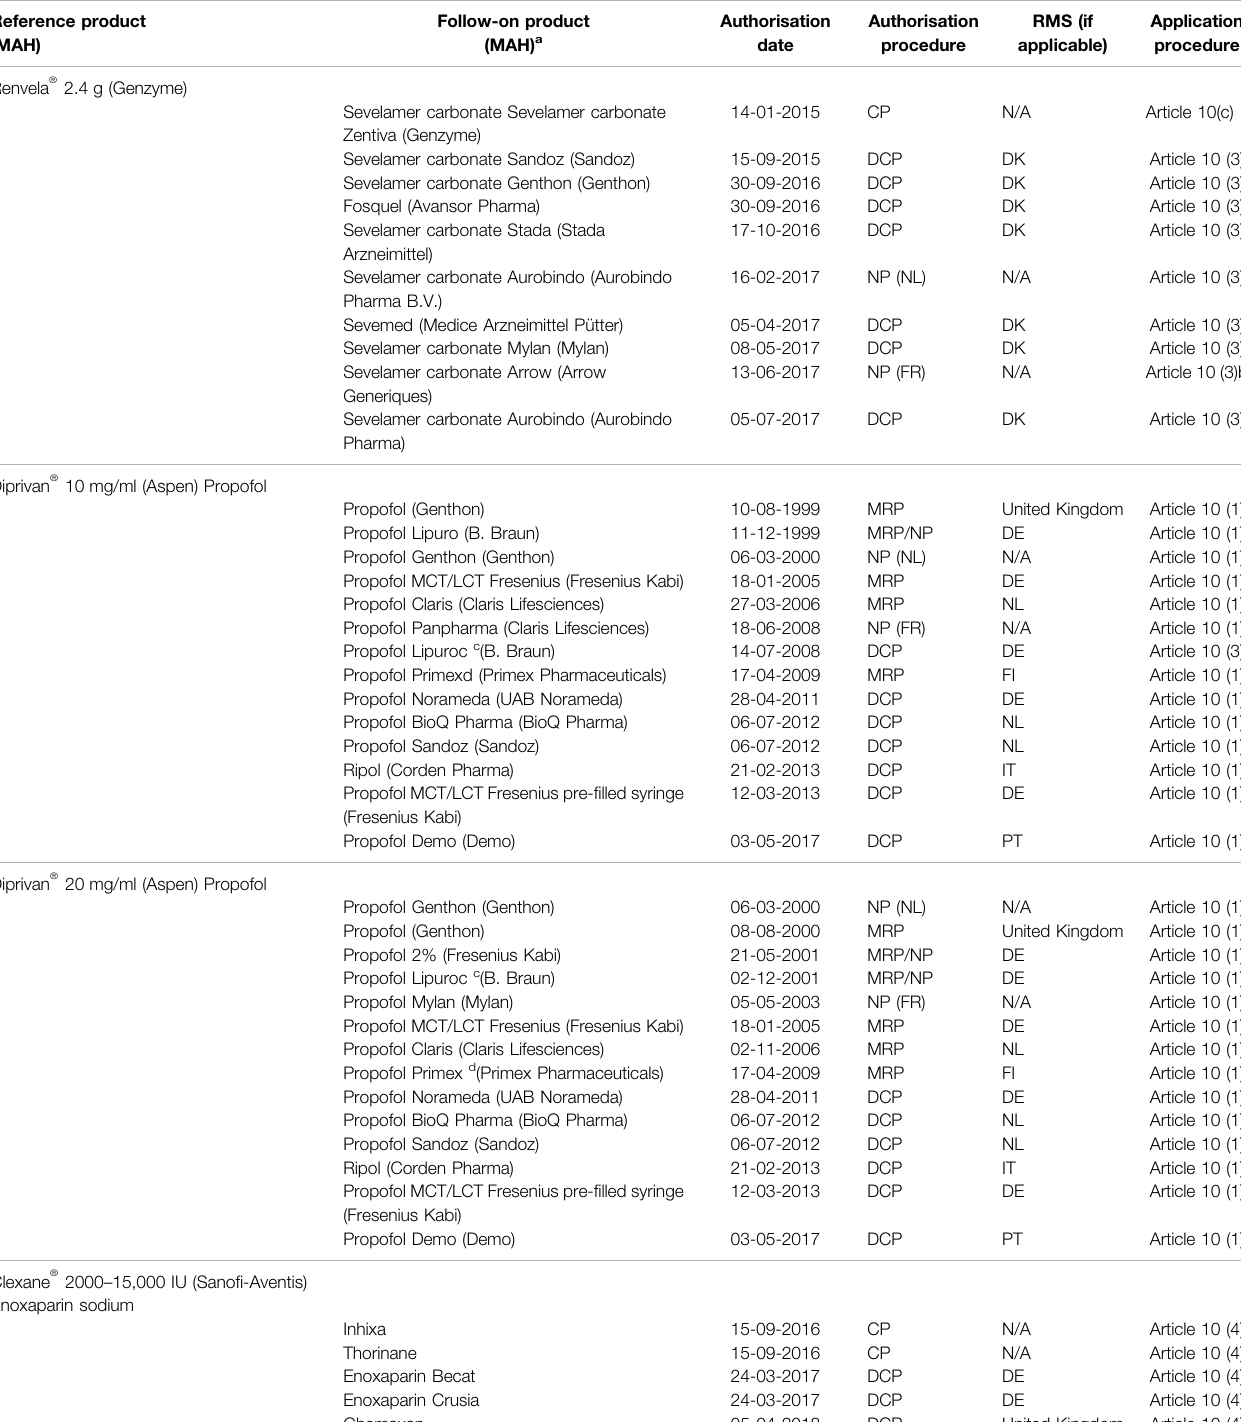
TABLE2| ( Continued )OverviewofNBCDfollow-onproductsapprovedintheEU via thethreeabbreviatedapplications:generic,hybrid,andbiosimilarpathways,aswellas new applications by originator companies via informed consent, sorted by authorization date since the fi rst approval in 1999 until November